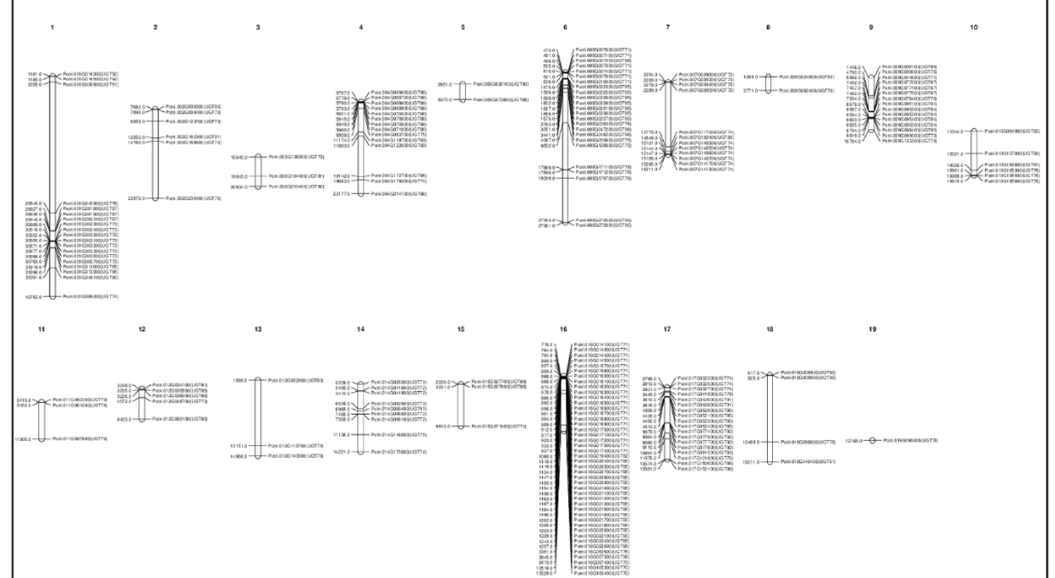
Figure 3. Chromosomal distribution of UDP glycosyltransferases (UGTs) across the Populus genome against the type of UGT gene . Except chromosome 04, all the remaining 19 chromosomes had UGT genes. The maximum number of UGT genes were found on chromosome 16.